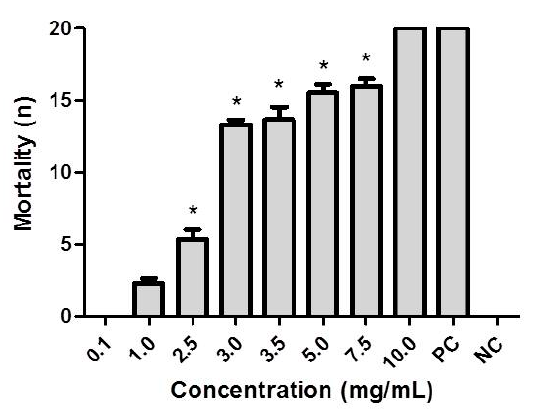
Figure 2. Larvicidal activity of different concentrations of Crude Ethanolic Extract (CEE) of H. velutina on A. aegypti larvae after 24 h. PC = Positive Control, NC = Negative Control. (*) Indicates results that are significantly different from controls.